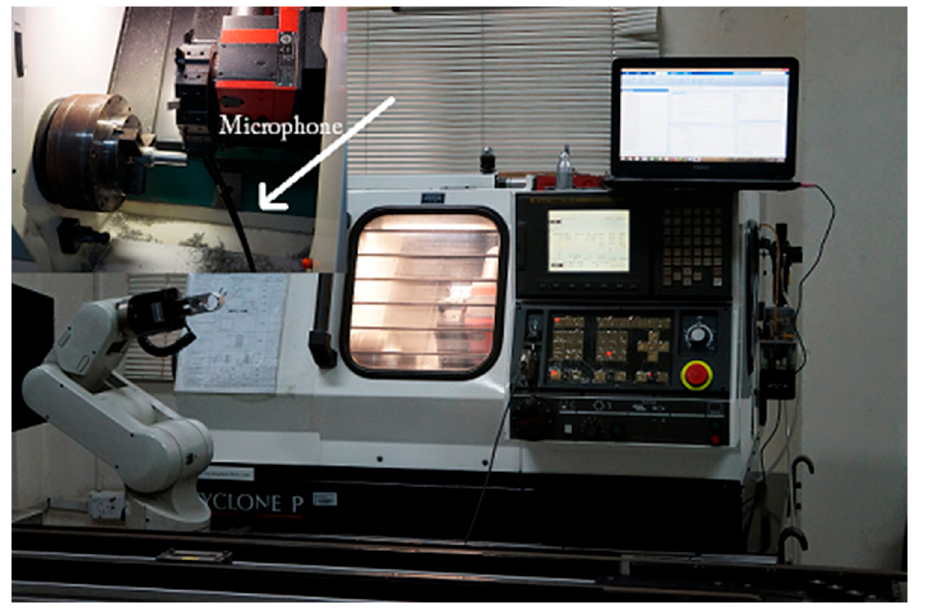
Figure 3 . ARMA-based reconstruction algorithm flowchart.